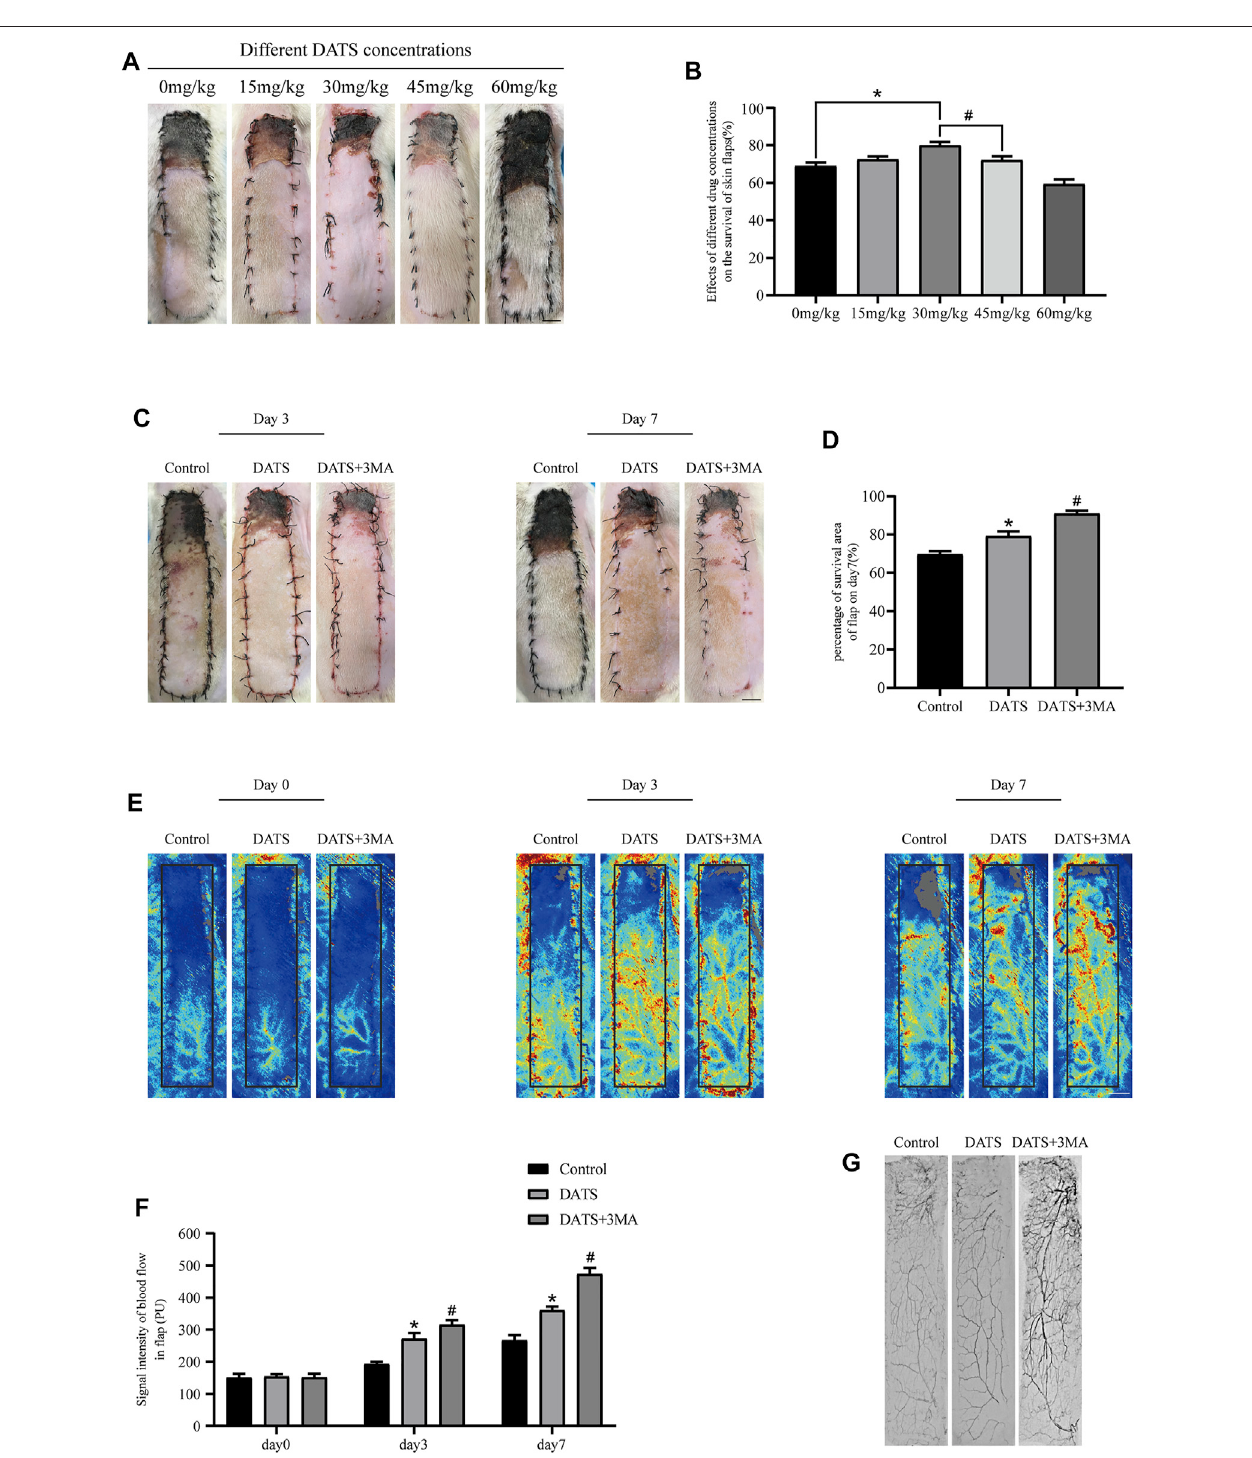
FIGURE2| DATSand3MAamelioratethesurvivalofmultiterritoryperforator fl ap. (A) EffectsofdifferentdosesofDATSonthesurvivalareaonPOD7. (B) Statistical chart of survival area of skin fl ap treated with different doses on POD 7. (C) Digital high-de fi nition photos of fl ap survival/necrosis area in the control, DATS, and DATS+3MA groups on the 3rd and 7th PODs. (D) Statistical chart of survival area of skin fl ap in each group. (E) LDBF in a perforator fl ap in the control, DATS, and DATS+3MAgroupsonthe0th,3rd,and7thPODs. (F) Statisticalchartofthequanti fi edblood fl owsignalintensityineach grouponthe0th,3rd,and7thPODs. (G) Flap angiograms in each group on the 7th POD. * p < 0.05, vs. control group; # p < 0.05, vs. DATS group. The obtained data were expressed as means ± SEM, n = 6 for every group. DATS, diallyl trisul fi de; 3MA, 3-methyladenine; POD, postoperative day; LDBF, laser Doppler blood fl ow.